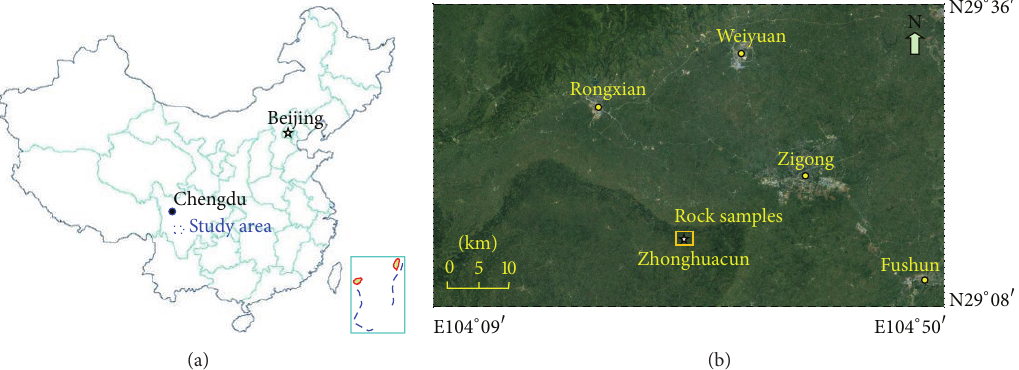
Figure 1: Location of the test samples for red-bed soft rock: (a) site location of the study area and (b) the Zigong argillaceous siltstone samples are collected from the Zhonghuacun reservoir